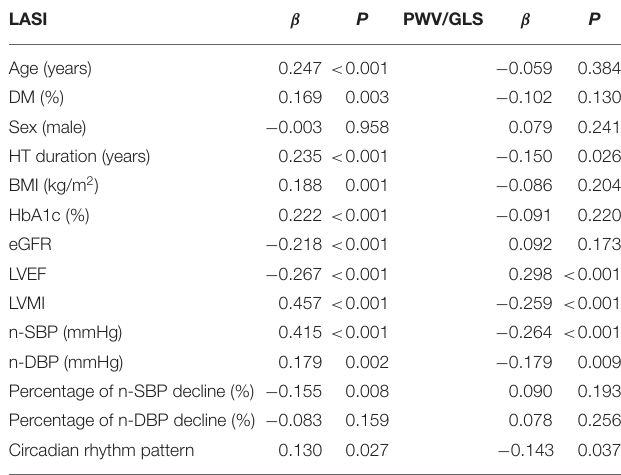
TABLE 5 | Univariate linear regression